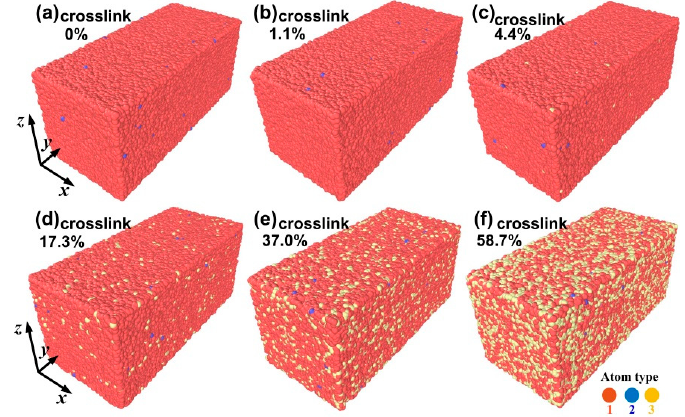
Figure 1. The three-dimensional molecular configuration of the crosslinked polymers consisting of 180,000 beads under uniaxial tension at T = 0.1 when the strain is equal to 0.8 (the three atom types of the inset represents middle bead ( red ), end bead ( blue ), and the crosslinked bead of the middle bead ( yellow ), respectively). ( a ) Configuration of linear polymers (two type beads (middle beads and end beads) can be found in the configuration); ( b ) configuration of crosslink density of 1.1%;